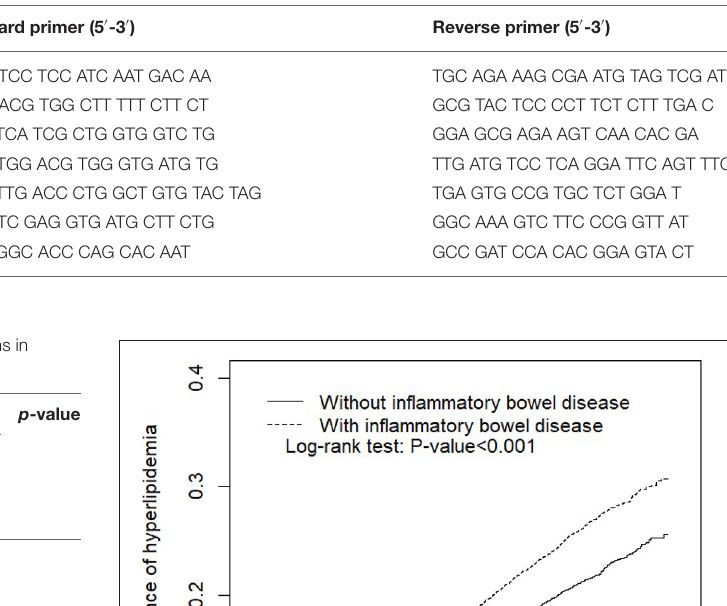
TABLE 1 | Sequences of PCR primers.